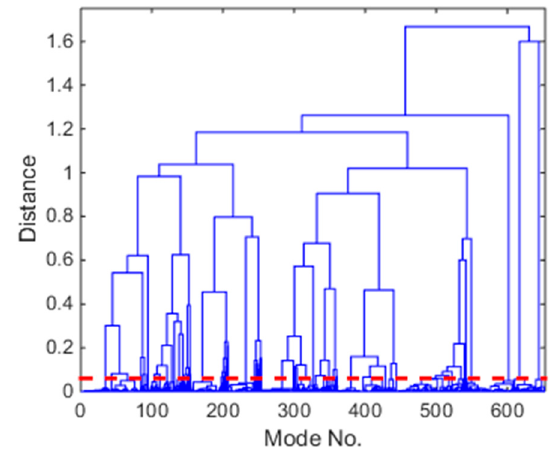
Figure 6. Dendrogram of the hierarchical clustering step (full lines), and automatically determined cut ‐ off distance (bold dashed line).